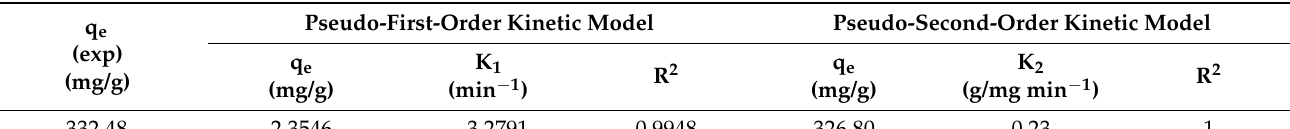
Table 2. Correlation and constant coefficients of pseudo-first- and pseudo-second-order kinetic models for the adsorption of AR88 onto ZL-CH hydrogel.